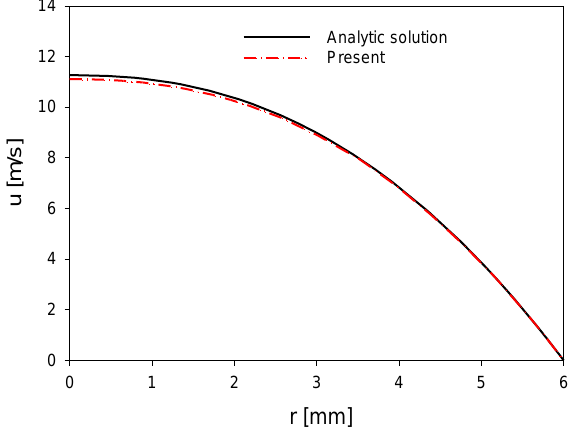
Figure 5. Comparison of Hagaen–Poiseuile flow and numerical result for non-Newtonian fluid.